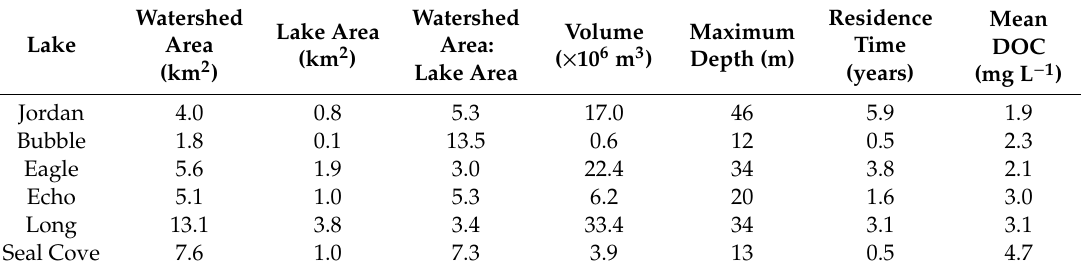
Table 1. Select characteristics of the six study